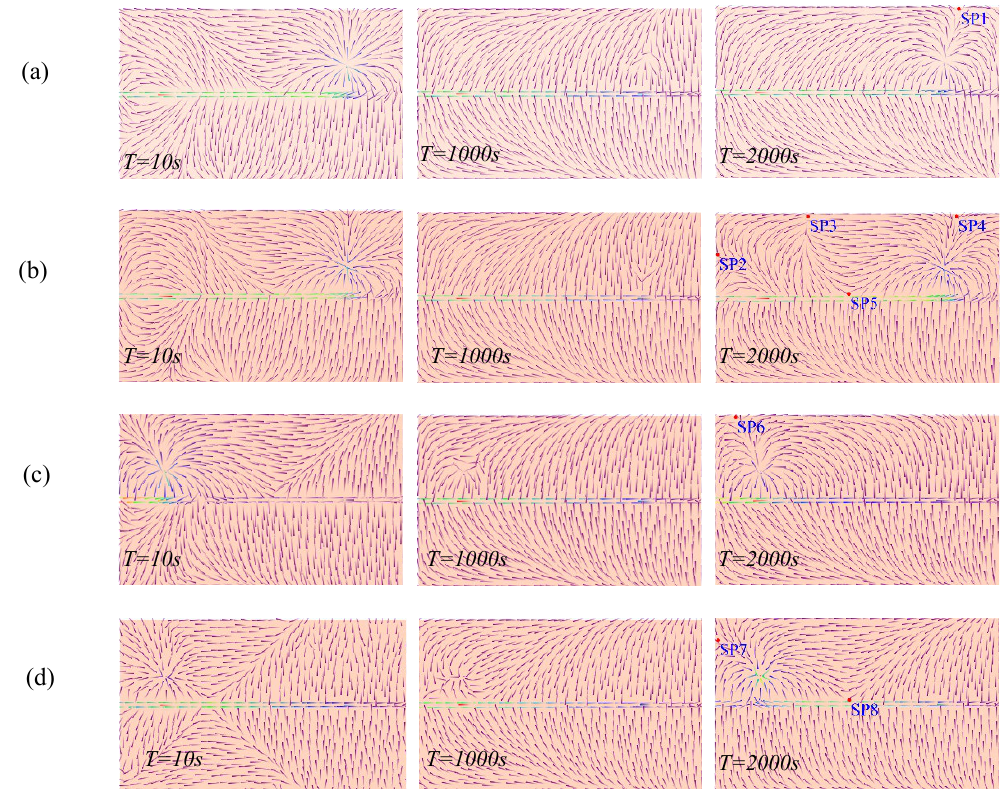
Figure 21. Flow fields regulated in fissures zone at different times. ( a ) Injected in fissures zone at the upstream location. ( b ) Pumping in fissures zone at the upstream location. ( c ) Injected in fissures zone at the downstream location. ( d ) Pumping in fissures zone at the downstream location.